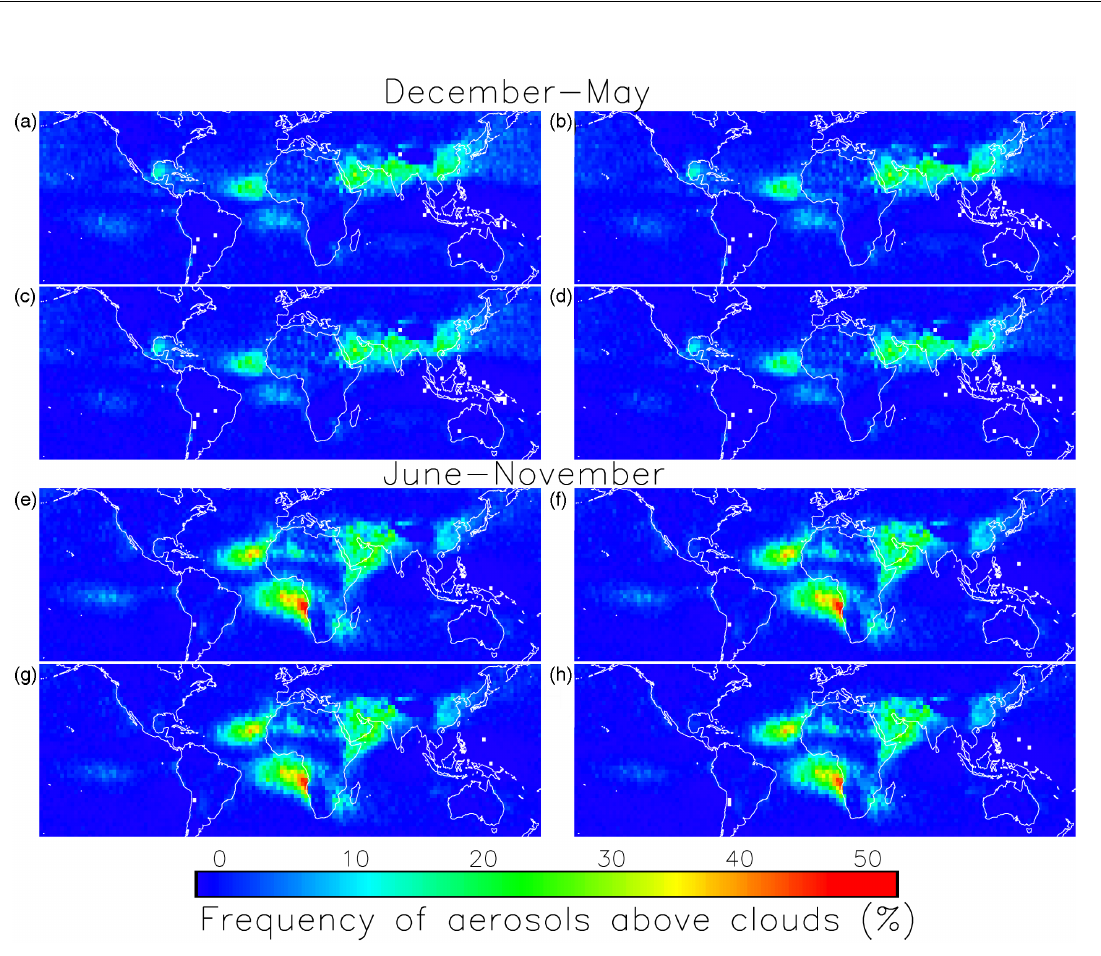
Figure 1. (a–h) Multi-year (2006–2013) CALIOP-derived daytime global cloudy-sky ACA frequency applying different CALIOP AODs as the threshold between background and significant aerosol loading. The CALIOP AODs are binned into 2.5 ◦ × 2.5 ◦ bins derived using the CALIOP cloud and layer data sets. CALIOP AOD baseline thresholds of 0, 0.010, 0.015, and 0.020 are applied to (a, b, c, d) , respectively, for the December–May period. Panels (e–h) show similar results to (a–d) but for the June–November